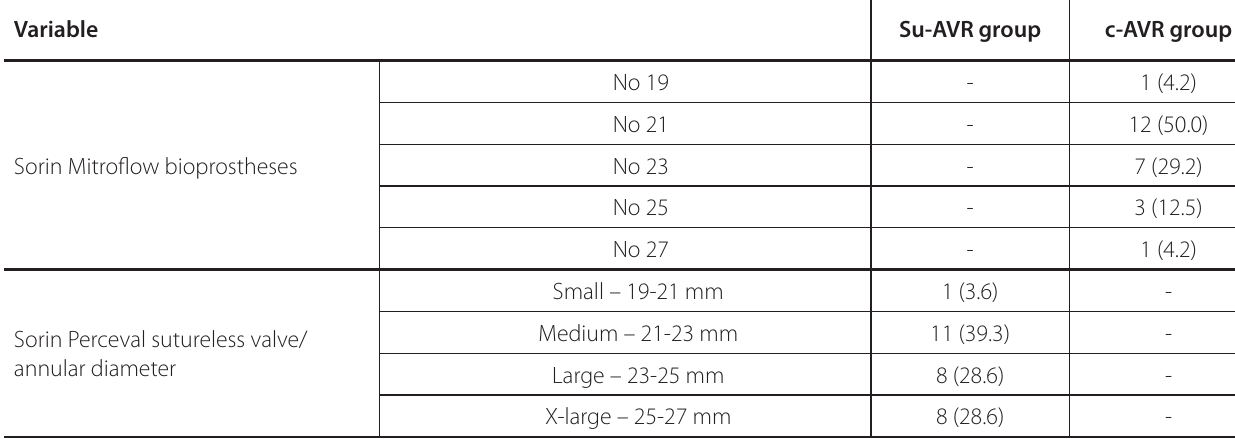
Table 2 . Distribution of implanted prosthetic aortic valve sizes.